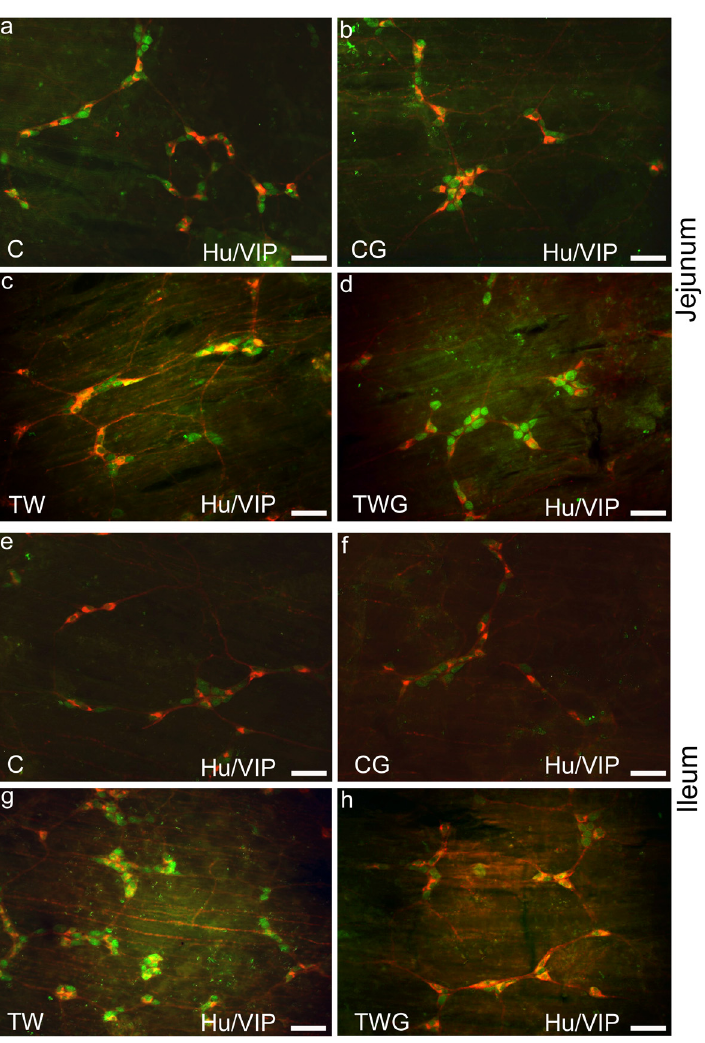
Fig 2. Representative photomicrographs of Hu/VIP submucous neurons. Double immunostaining of HuC/D and VIP submucous neurons of jejunum (a-d) and ileum (e-f) from experimental groups: control (C); control supplemented with 2% L-glutamine (CG); Walker-256 tumor (TW); and Walker-256 tumor supplemented with 2% L-glutamine (TWG). These images are composites of merged images taken separately from red (VIP) and green (HuC/D) fluorescent channels. Scale Bar 50 μ